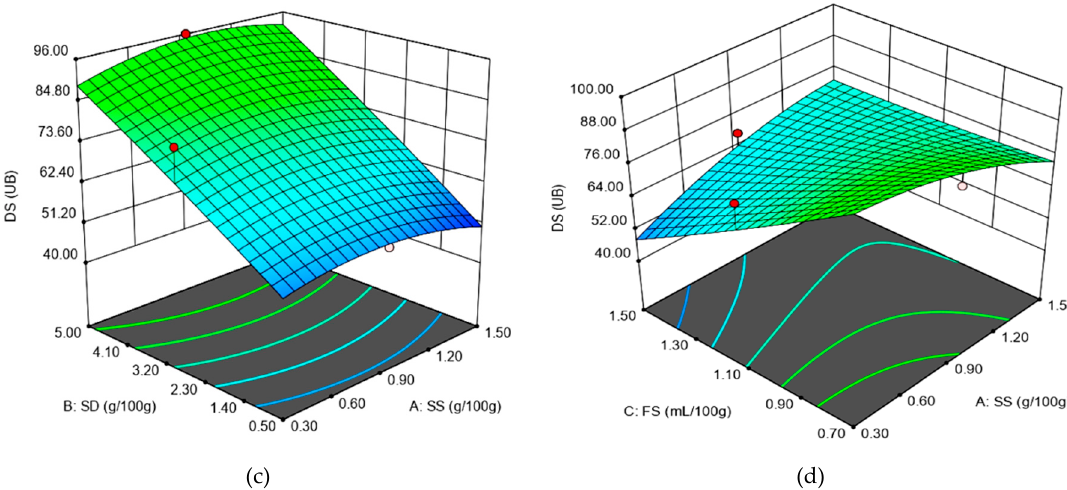
Figure 1. The graphical representations of the Farinograph parameters: ( a ) stability (ST) as affected by the levels of sea salt (SS) and dry sourdough (SD) incorporated in wheat flour at 1.10 (mL/100 g) fermented sugar; ( b ) stability (ST) as affected by the levels of sea salt (SS) and fermented sugar (FS) incorporated in wheat flour at 2.75 (g/100 g) dry sourdough; ( c ) degree of softening at 10 min (DS) as affected by the levels of sea salt (SS) and dry sourdough (SD) incorporated in wheat flour at 1.10 (mL/100 g) fermented sugar; ( d ) degree of softening at 10 min (DS) as affected by the levels of sea salt (SS) and fermented sugar (FS) incorporated in wheat flour at 2.75 (g/100 g) dry sourdough.